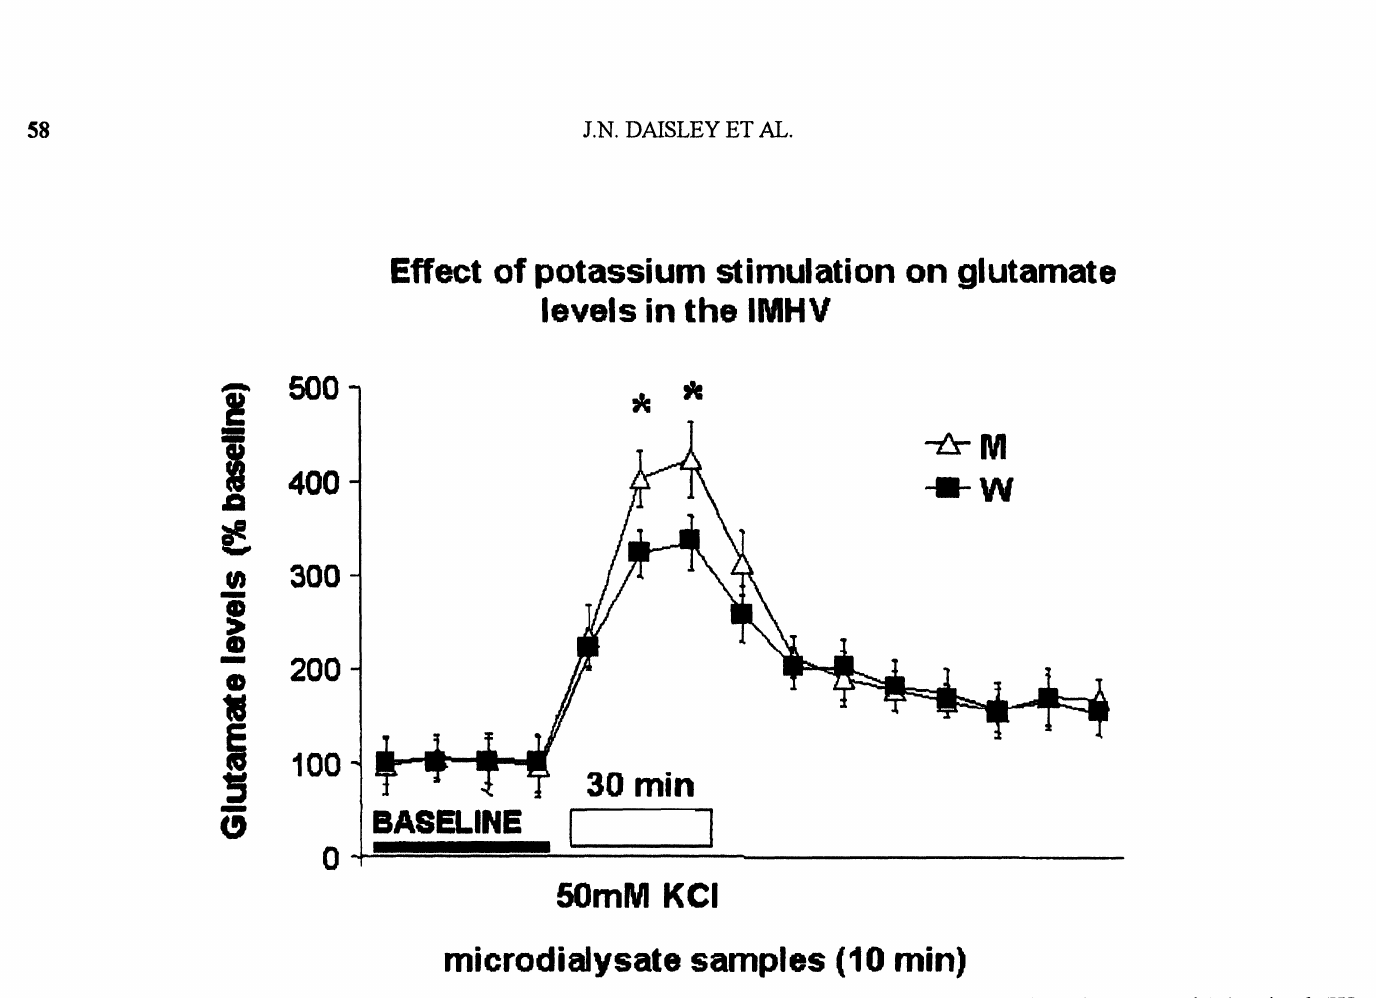
o potassium stimulation on in vivo lutamate release from the left IMHV of MeA- (M) and W-trained (W) Fig 2: The effect chicks. Data are mean +/- SEM (bars) values. The horizontal bar indicates the 30 min of stimulation with 50-mM potassium. *p<0.05 between groups (Mann-Whitney U-test).